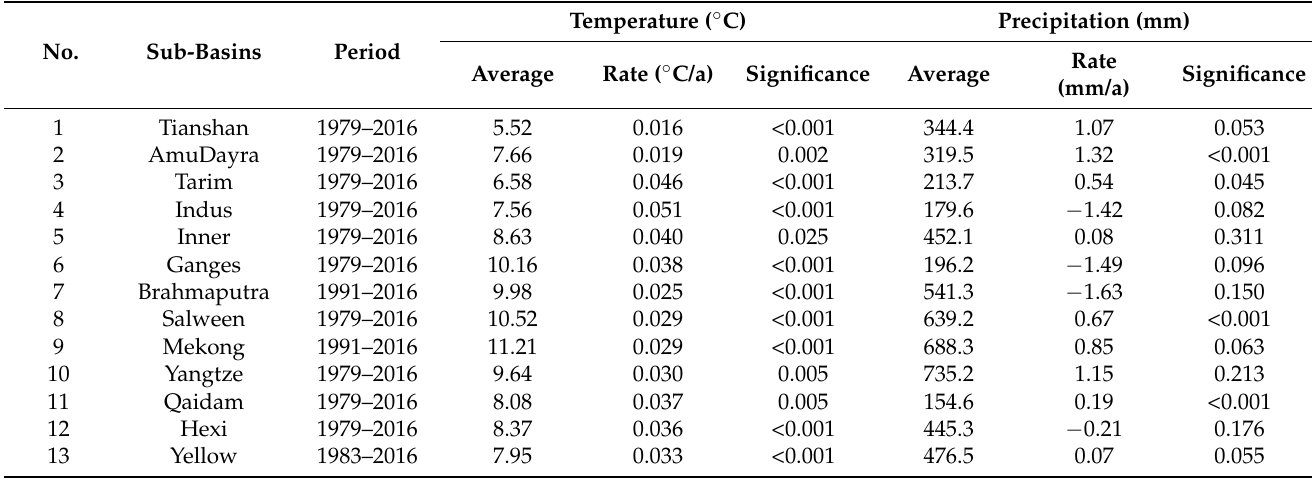
Table 2. Variation of linear trends of temperature and precipitation calculated from meteorological stations in each sub-basin for